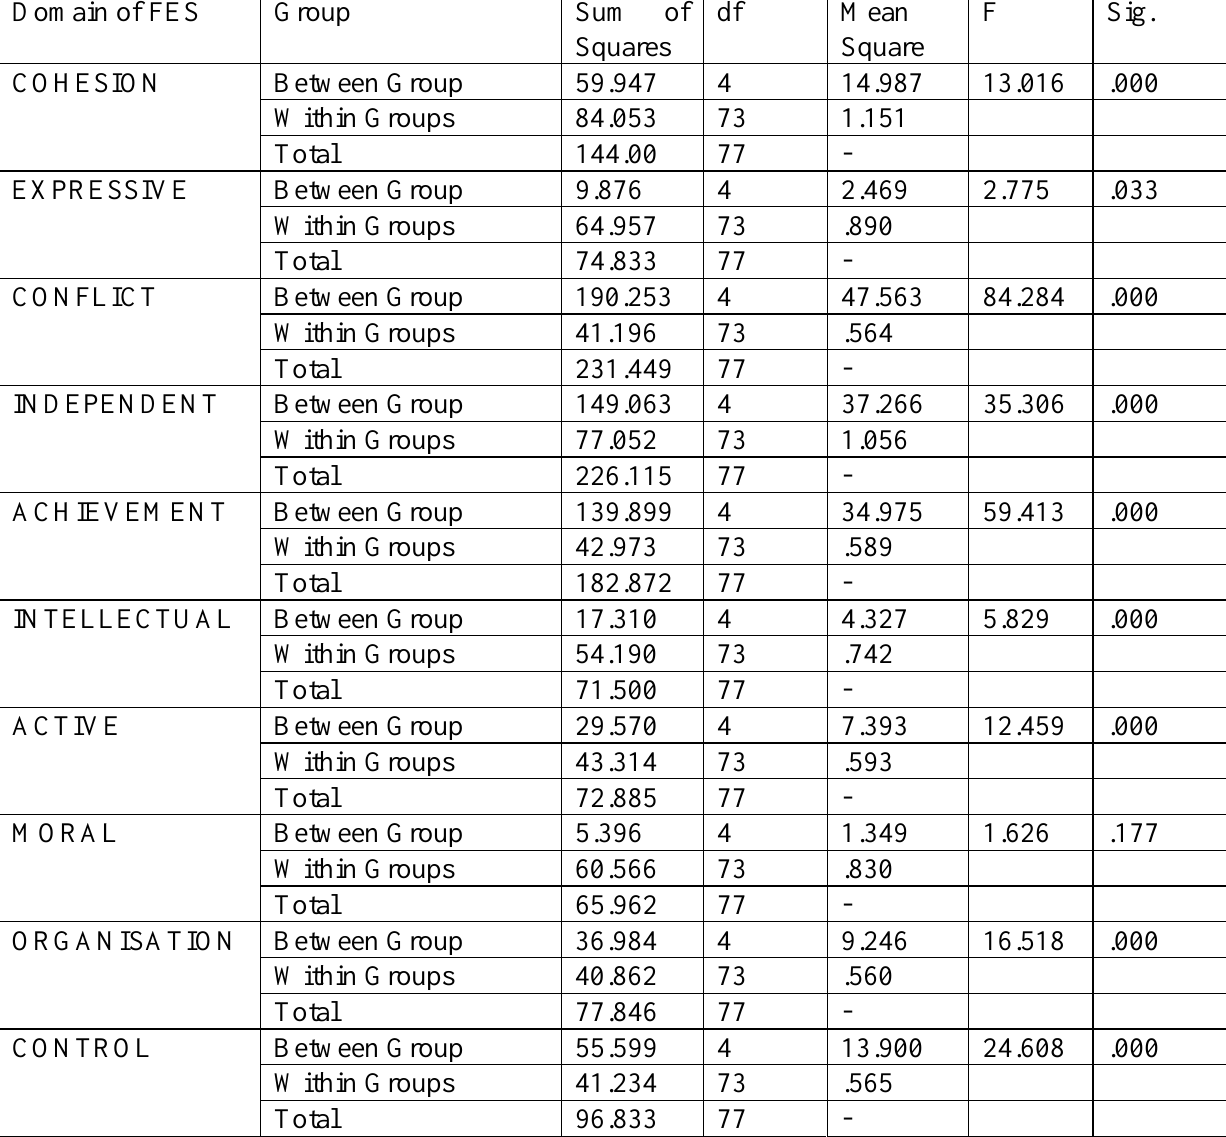
Table 7. Comparison of scores on different measures of family environment scale